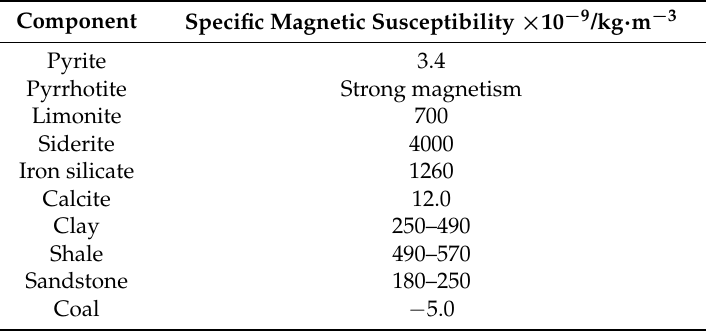
Table 2. Specific magnetic susceptibility of major minerals in